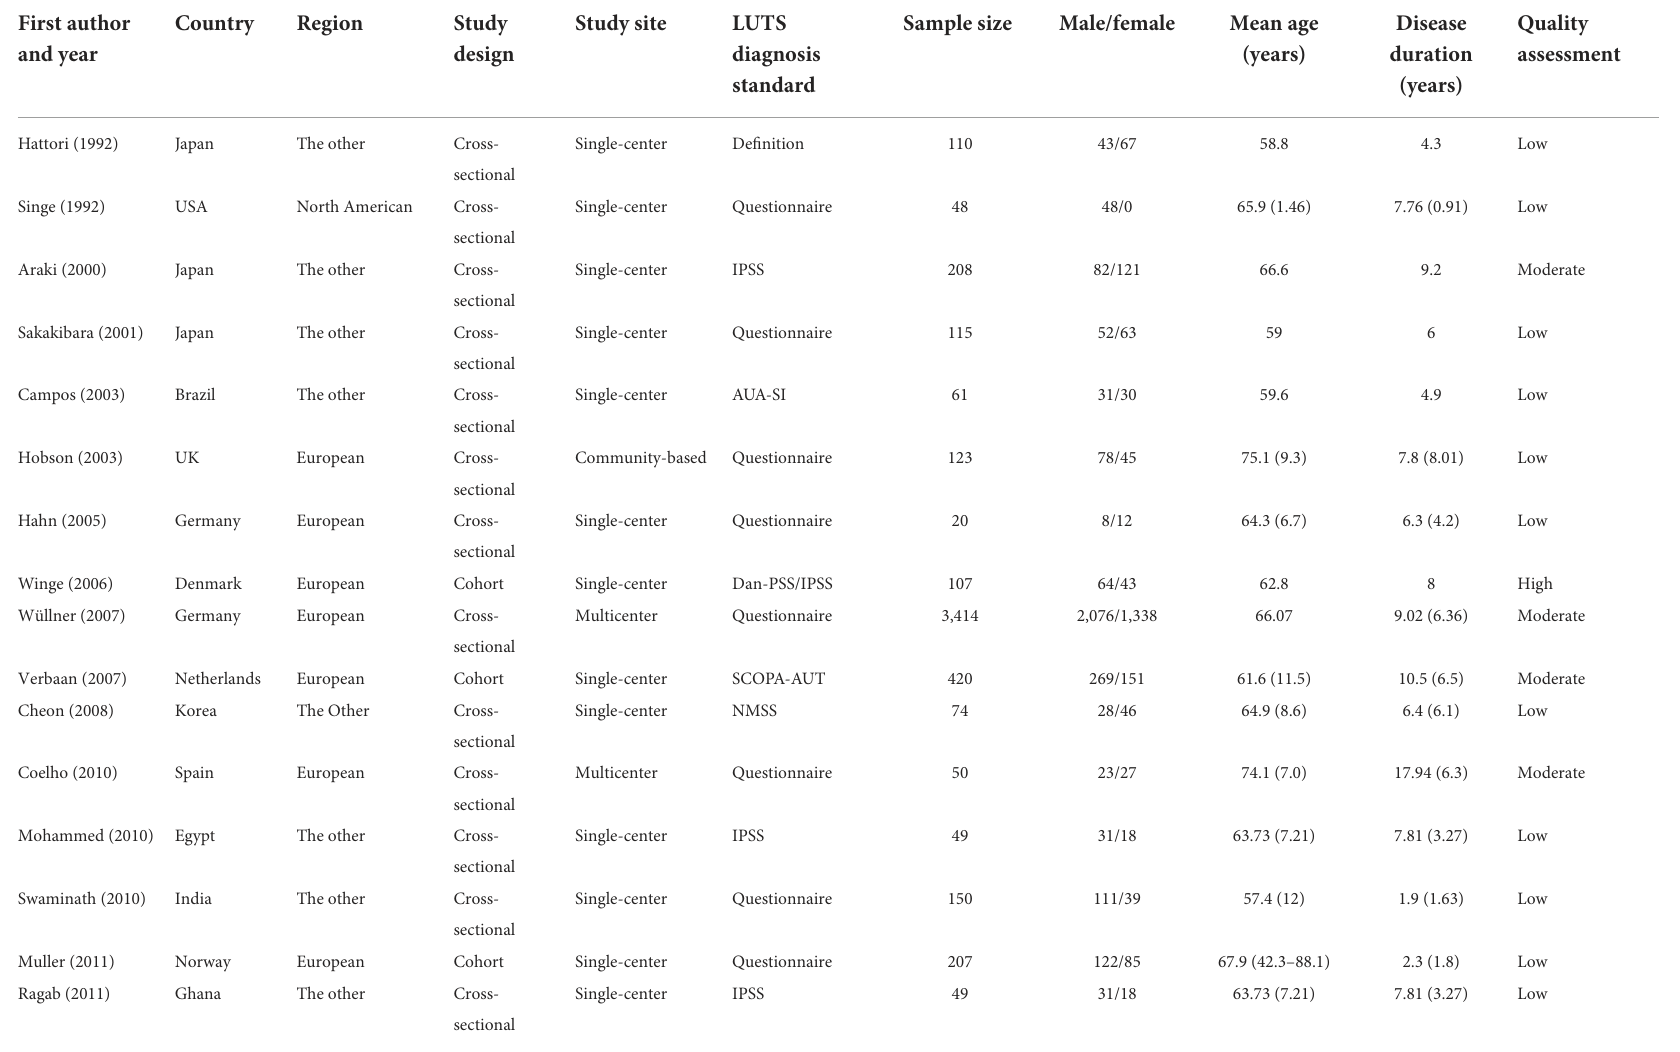
TABLE 1 Characteristics of studies included in the